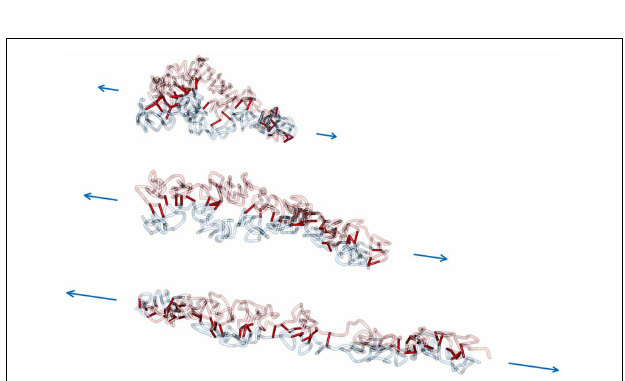
FIGURE 7 | Force extension of interlinked model sister chromatids. In this scenario, a non-zero linking probability p link and mean link lifetime τ link is assumed. Consequently, the sister chromatids are aligned to each other during the whole pulling process. For large pulling forces the model chromatids disintegrate, but are still attached to each